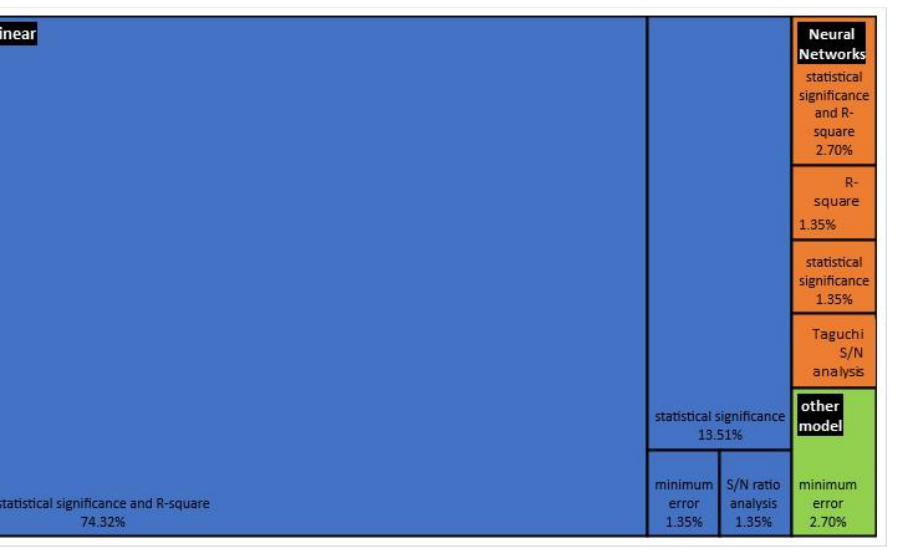
Figure 12. Optimization stage.